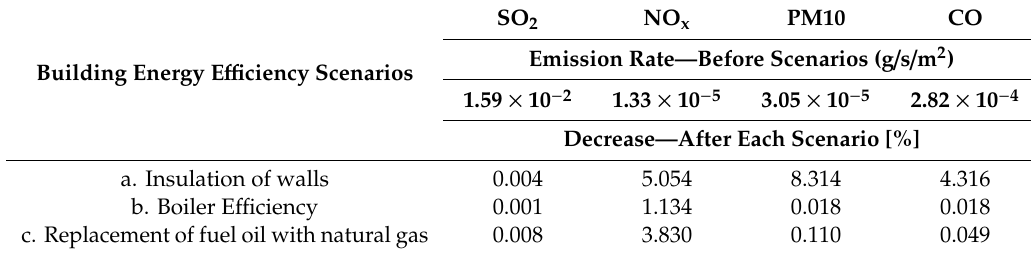
Table 7. Area averaged emission rates calculated in the present study for all sources before and (%) decrease after each EPBD implementation